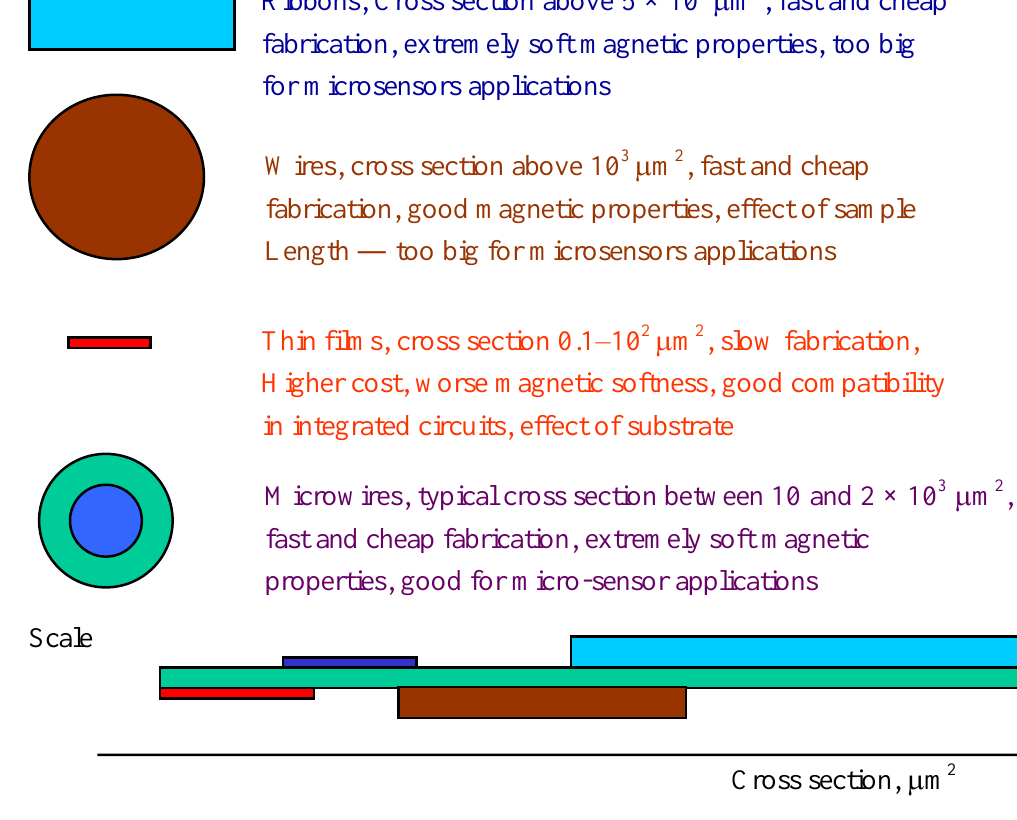
Cross section,  m